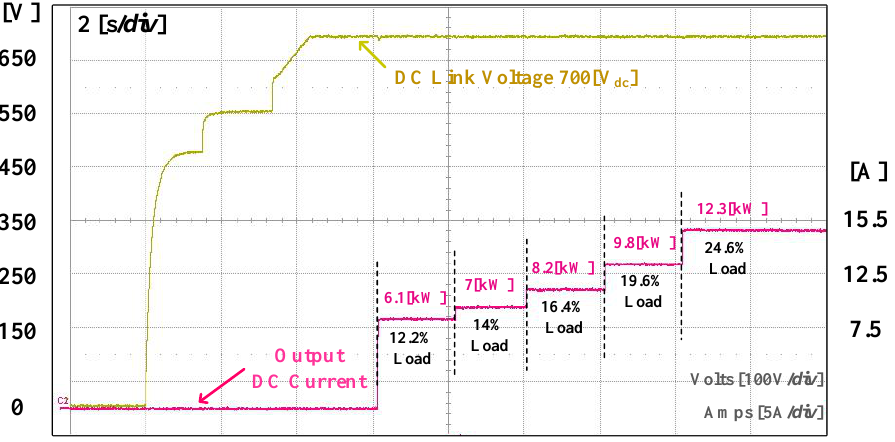
Figure 25. Waveform of 3-phase AC/DC PWM converter operation.